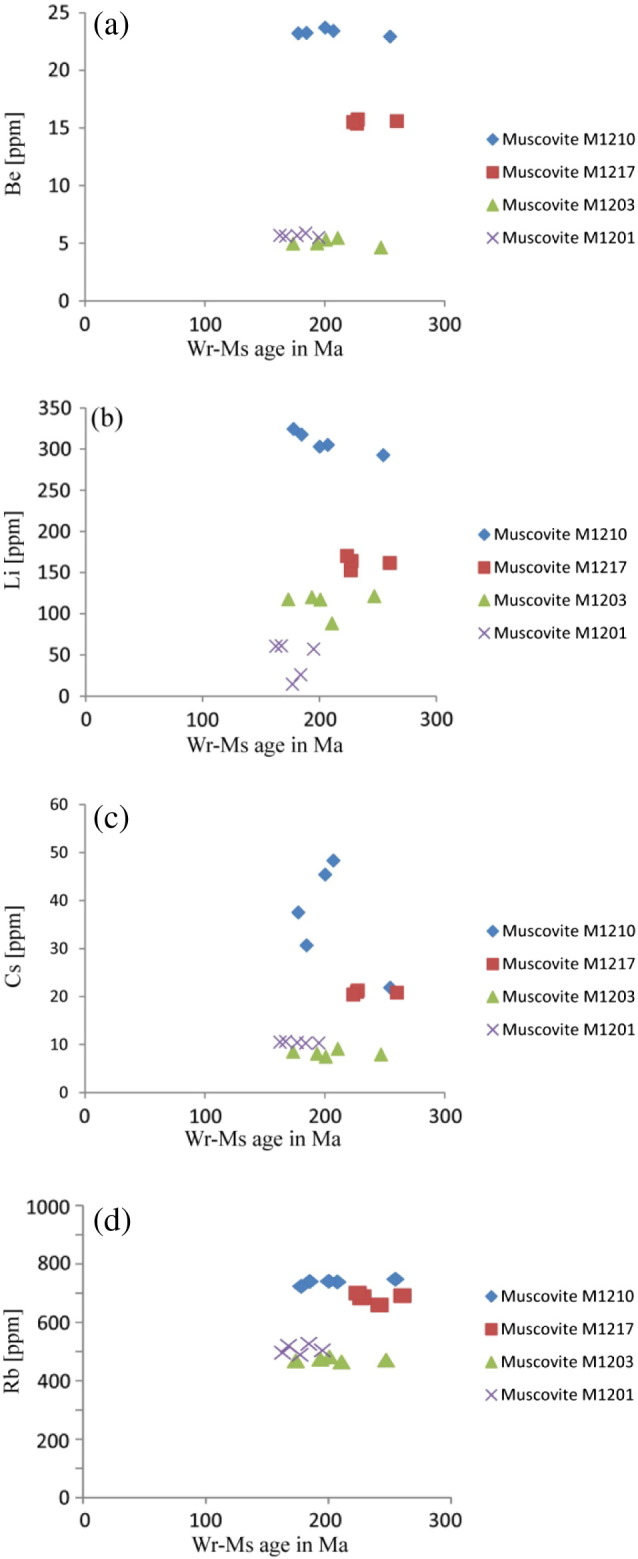
Plots of (a) Be-, (b) Li-, (c) Cs- and (d) Rb-concentrations vs Rb–Sr muscovite–whole rock apparent age. Note, that none of these elements show a positive correlation with the mineral–whole rock age.